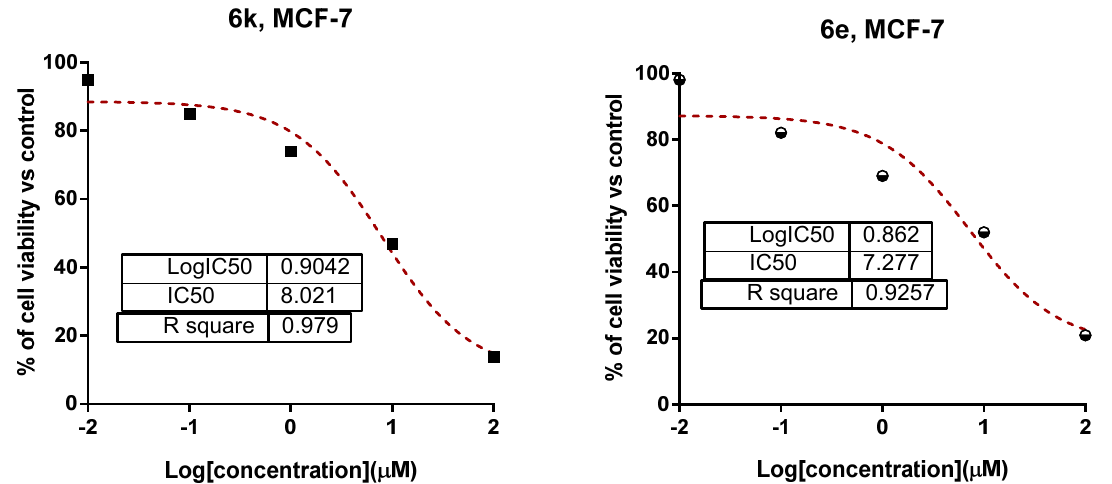
Figure 4. Dose–response nonlinear regression curve fitting the percentage of cell viability vs. log [conc. µM], R square = 1 using the GraphPad prism.